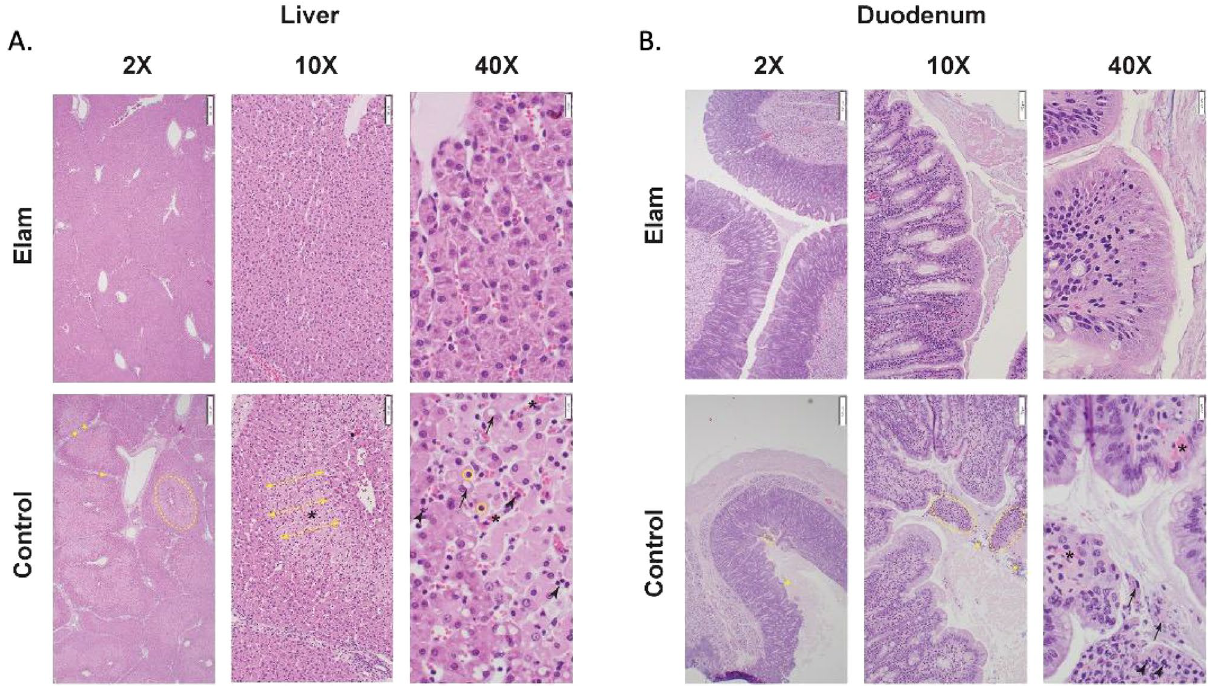
Figure 4. ( A ) . Histologic liver sections from control and Elamipretide-treated pigs presented at various magnifications. At 2× magnification, there is evidence of centrilobular to midzonal necrosis characterized by hepatocytes pallor (dashed yellow ellipse) in the control pigs but not in the Elamipretide-treated pigs. Also, interlobular space is widened in controls due to lobular collapse and edema. At 10× and 40× magnification, the sinusoids in the areas of pallor (double-edged yellow arrows) contain large numbers of red blood cells (asterisk) and polymorphonuclear cells (arrowhead). The hepatocytes in the areas of pallor exhibit various features of cellular degeneration characterized by cytoplasmic vacuolation, nuclear pallor (black arrows), and nuclear pyknosis (yellow circles). ( B ) . Histologic sections of the duodenum from control and Elamipretide-treated pigs presented at various magnifications. At 2× magnification, the differences between control and treated pigs’ duodenal sections are not readily apparent. At 10× magnification, the necrosis and sloughing of villous tips are evident in controls but not in the treated pigs (dashed yellow ellipse). At 40× magnification, individual enterocyte pallor is noticeable in the Elamipretide-treated pigs, but the villous tips are not sloughing. In contrast, in the control pig sections, the entire villous tips are sloughed. The enterocytes are necrotic (black arrows) and are admixed with polymorphonuclear cells (arrowheads). Also, capillary congestion is more prominent in the controls (black asterisk). Yellow stars indicate bacterial